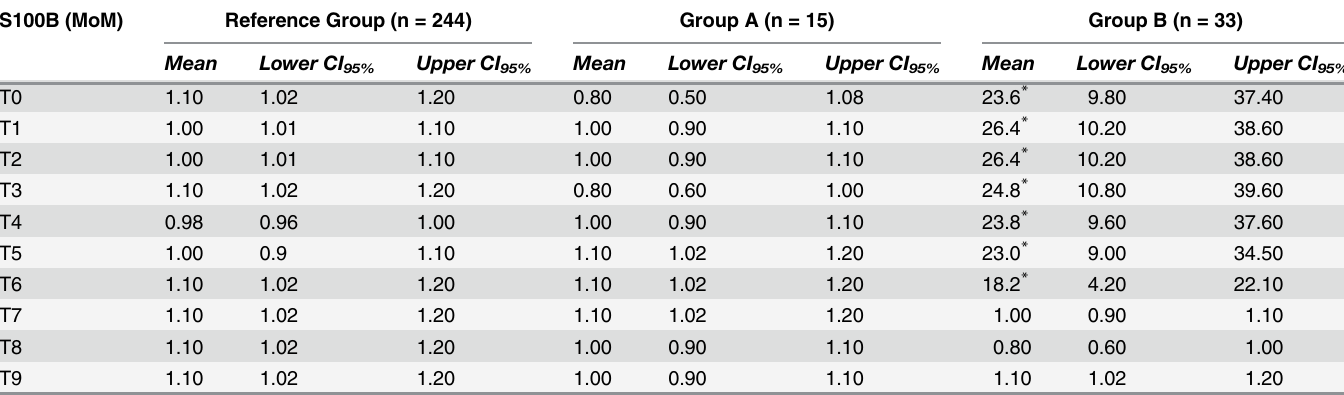
Table 3. Mean saliva S100B concentrations ( µ g/mL) expressed as MoM [lower and upper 95% Con fi dence Interval (CI)] at birth (T0) and at 4 (T1), 8 (T2), 12 (T3), 16 (T4), 20 (T5), 24 (T6), 48 (T7), 72 (T8) and 96 (T9) hours after birth in Reference Group (n = 244) and in asphyxiated full-term newborns with good (Group A) or severe (Group B) neurological outcome at 12-months follow-up.